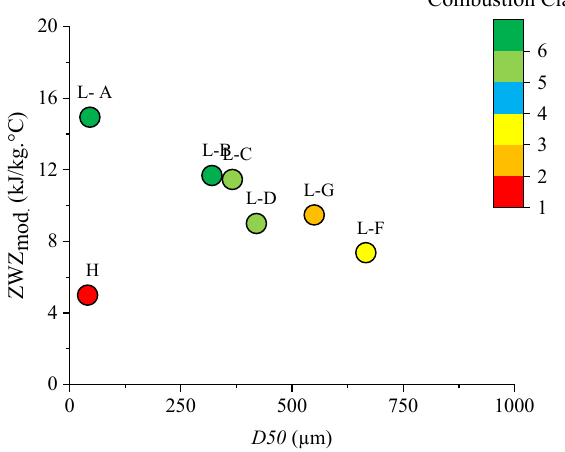
Figure 8. The Combustion Class versus the modified ignitability characteristic number.